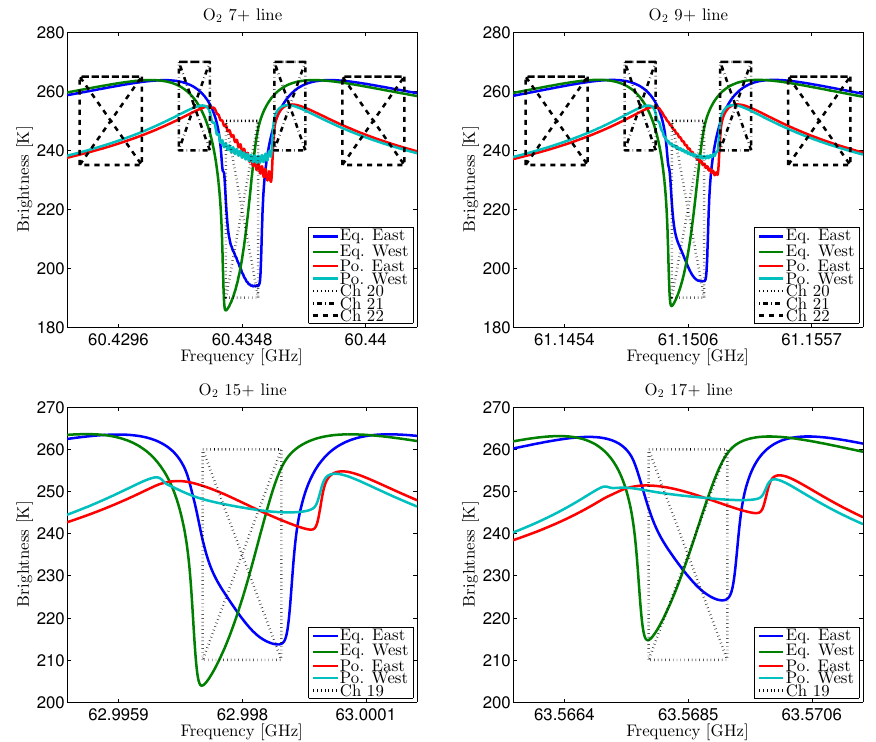
Figure 3. Channel configurations for SSMIS. The colors represent polar simulations (60 ◦ N 0 ◦ E; teal and red lines) and equatorial simu- lations (0 ◦ N 0 ◦ E; blue and green lines). The different colors also denote the simulations’ azimuthal angle; blue and red responses show SSMIS facing towards the east (75 ◦ ), whereas green and teal show it facing towards the west ( − 75 ◦ ). The channels are indicated by black boxes of different line styles as seen in the legends. The simulated measurement responses are assumed to be the average of the spectra within the frequency